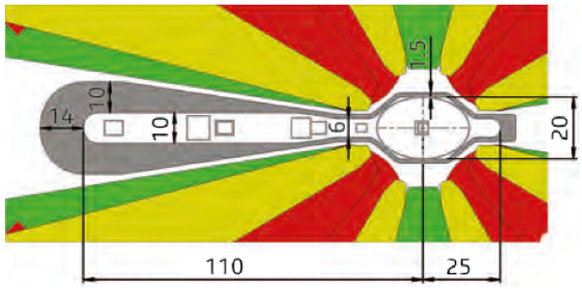
FIG. 1. The vacuum chamber profile for large vertical aperture. The beam passes through the chamber on the right-hand side, while the antechamber on the left is for the synchrotron